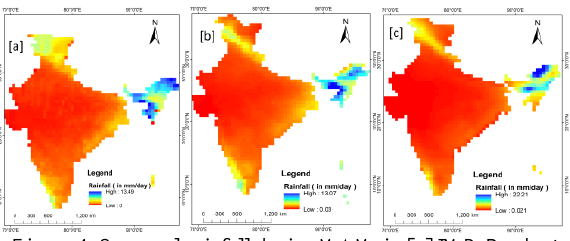
Figure 4. Seasonal rainfall during MAM in [a] IMD